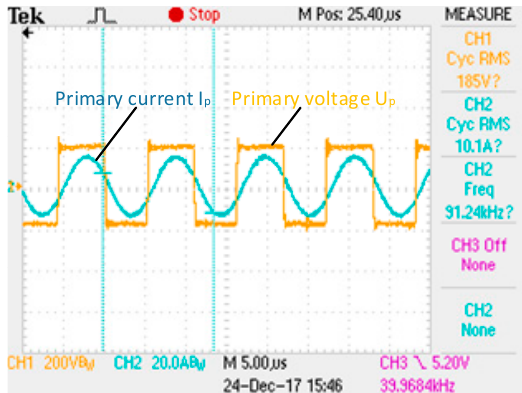
Figure 15. The voltage and current waveforms in the primary side at constant current stage.